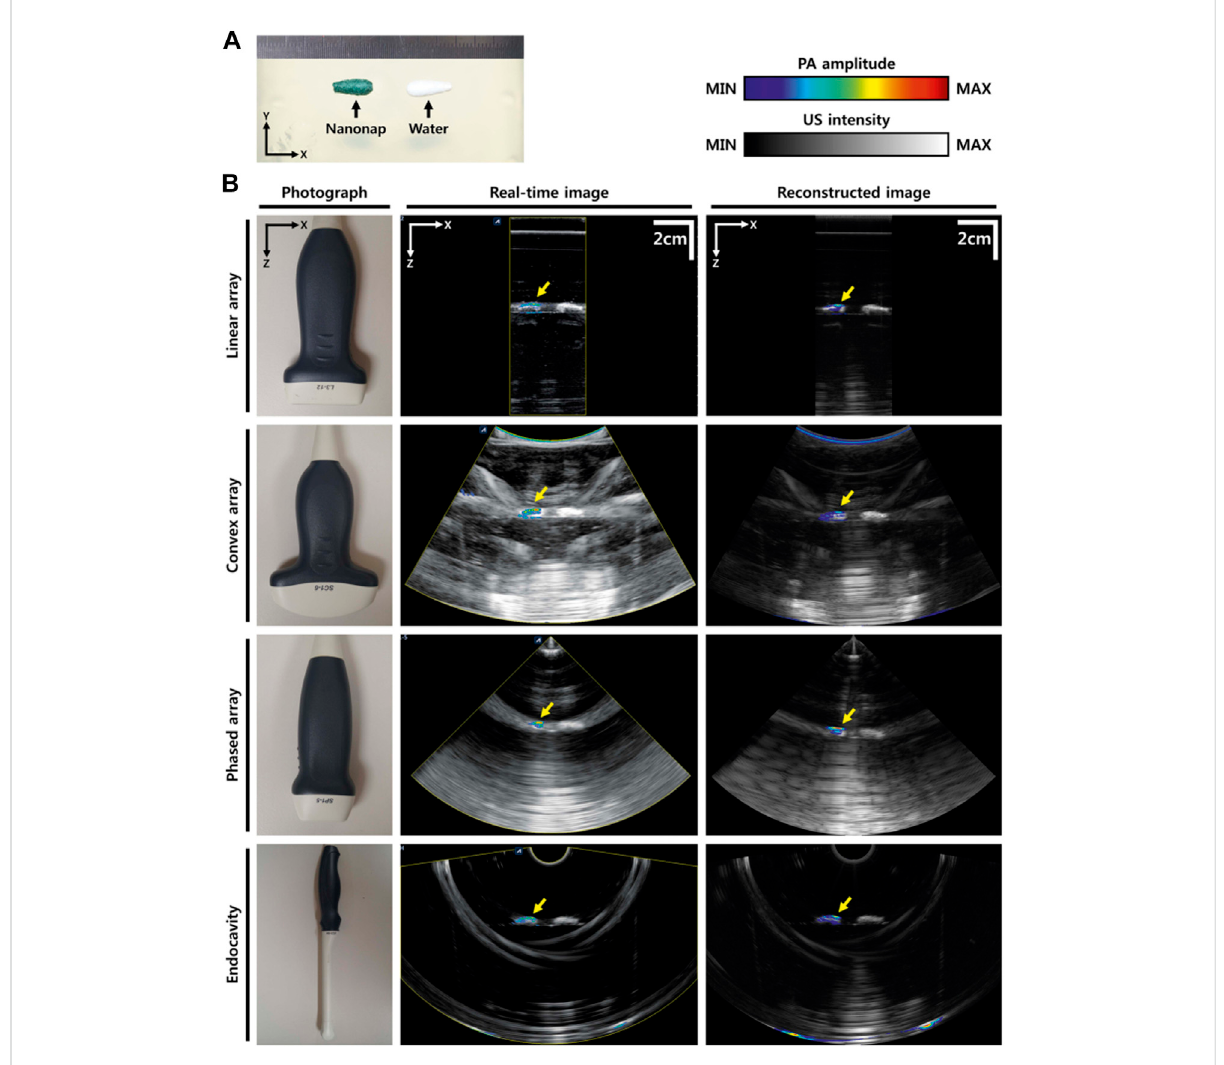
FIGURE 1 PAT/USimagesusingdifferenttransducers. (A) Photographofthephantom. (B) Photographsofdifferenttransducers(lineararray,convexarray, phased array, and intracavity transducers), real-time PAT/US images, and reconstructed PAT/US images acquired by these transducers. PAT, photoacoustic tomography; US, ultrasound. Reprinted with permission from [Kim J., Park S., Jung Y., Chang S., Park J., Zhang Y., et al. (2016). Programmable Real-time Clinical Photoacoustic and Ultrasound Imaging System. Sci Rep.6,35137. doi: